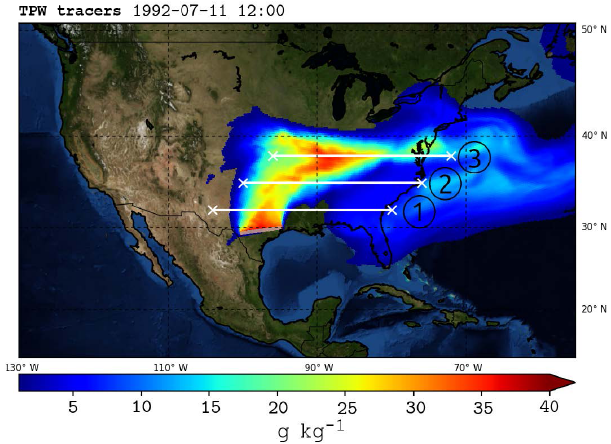
Figure 5. Tracer total precipitable water (TPW, gkg − 1 ) and posi- tions of the cross sections along the central axis of the GPLLJ shown in Figs. 6 and 7, at latitudes 32 ◦ N (1), 35 ◦ N (2) and 38 ◦ N (3) for the main jet event of 11 July